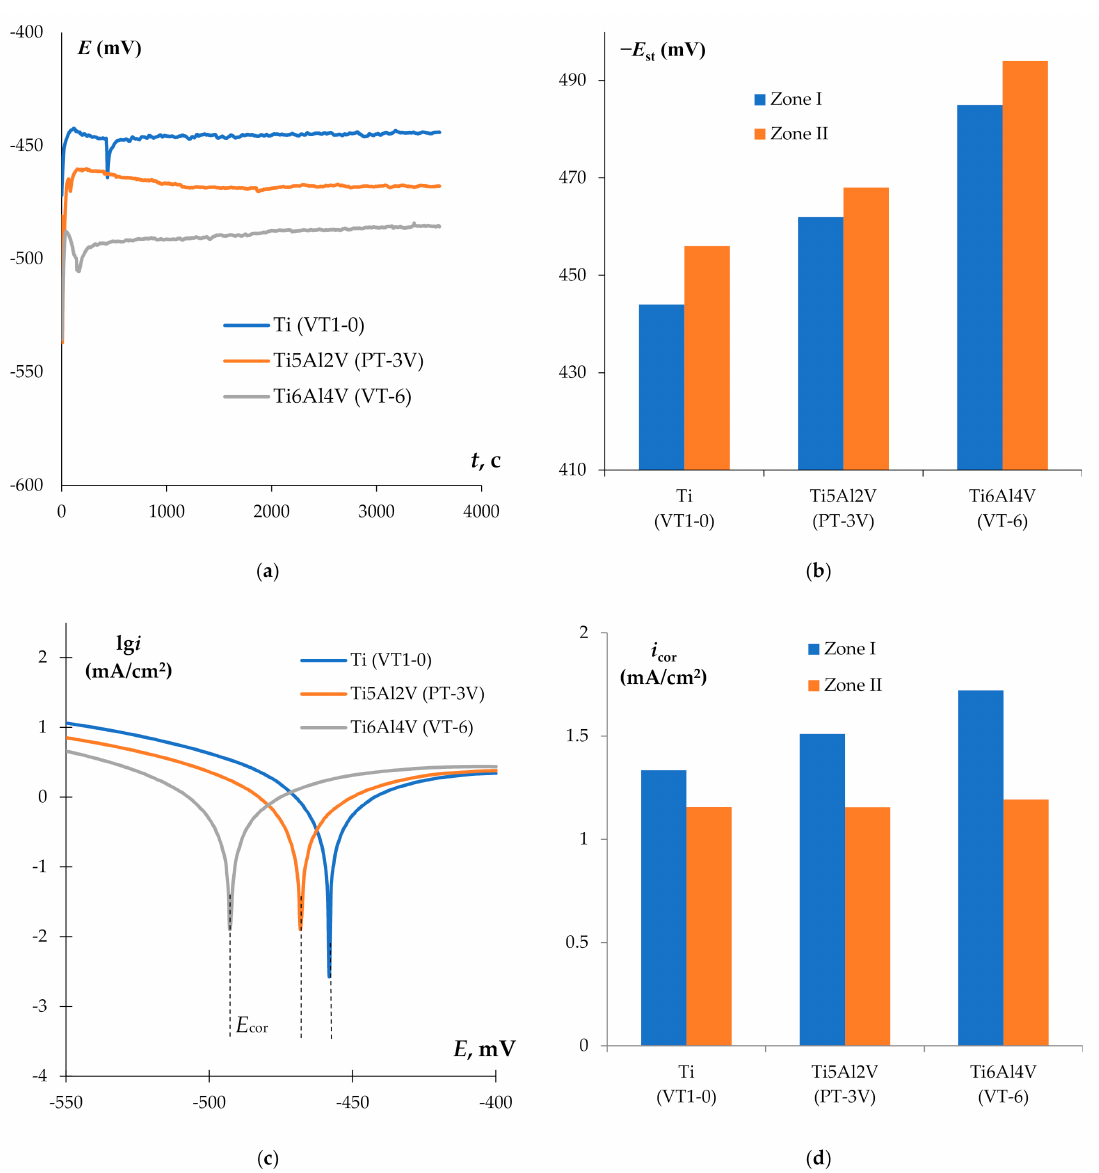
Figure 12. Results of electrochemical investigations of Ti alloys: ( a )—dependence of potential on the time of exposure to the electrolyte E ( t ) (Zone 2); ( b ) the values of stationary corrosion potential Е st for the alloys; ( c ) Tafel curves lg( i )- E (Zone 2); ( d ) the values of the corrosion current density i cor for the Ti